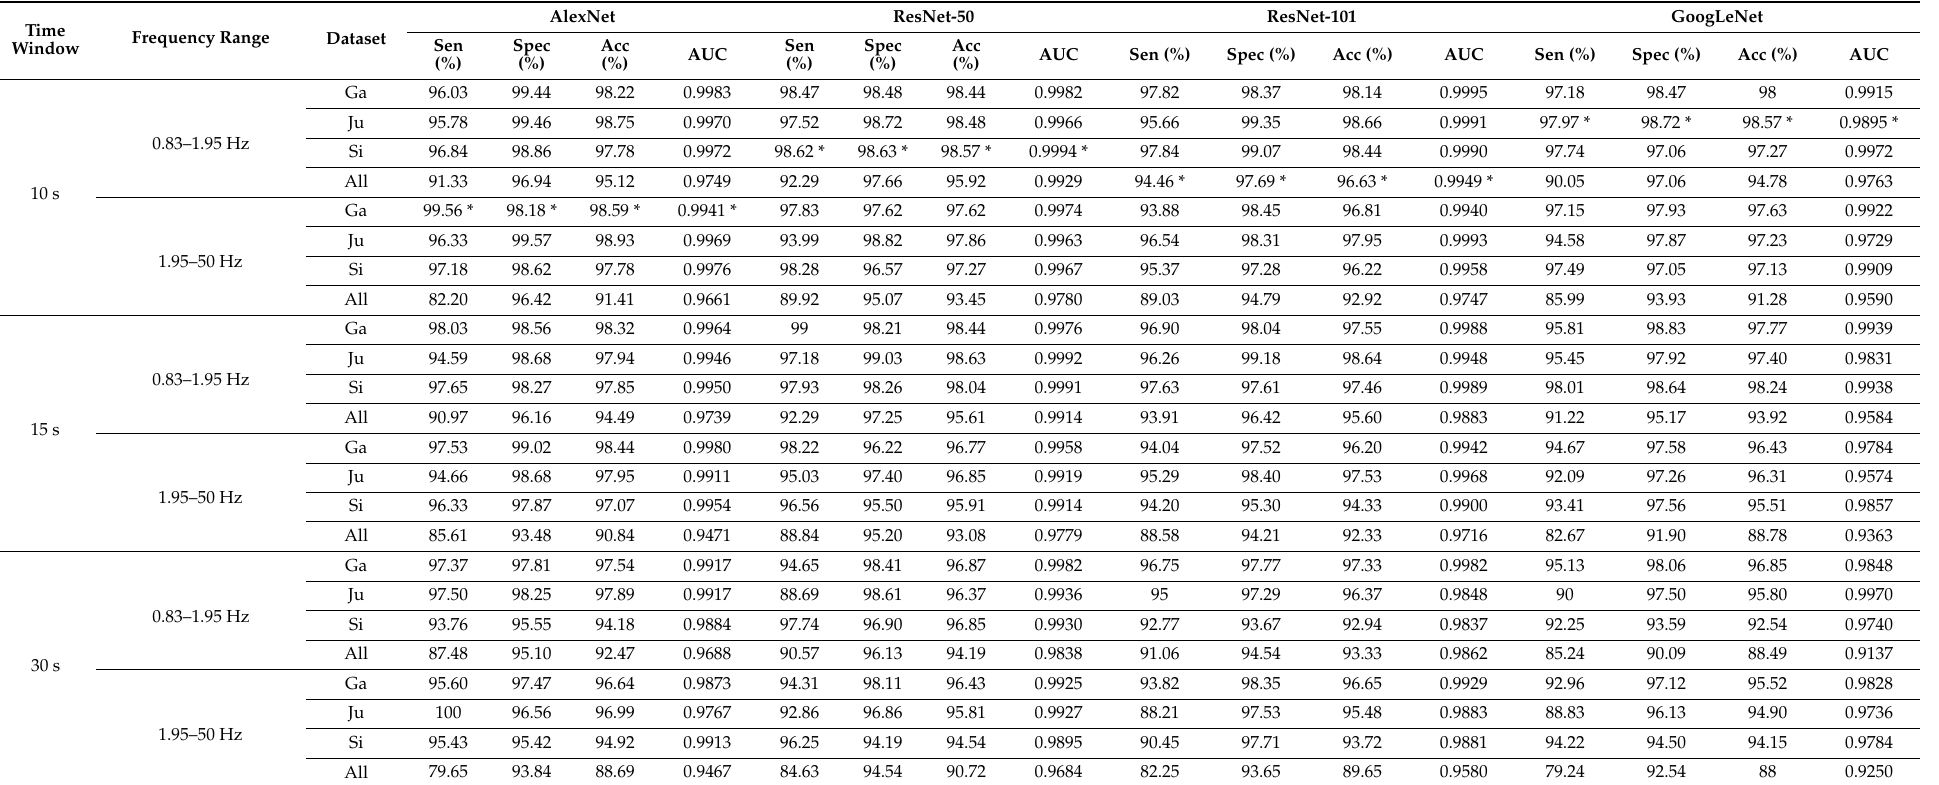
Table 18. Two-class classification of RF for CO and PD (Class 2, Class 2.5, and Class 3) using several CNN classifiers (AlexNet, ResNet-50, ResNet-101, and GoogLeNet) with 10-fold